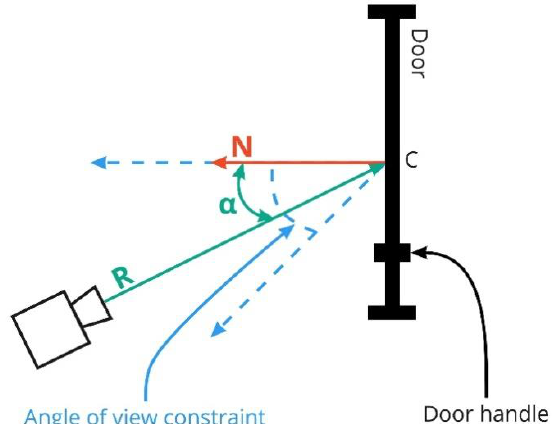
Figure 7. Covering